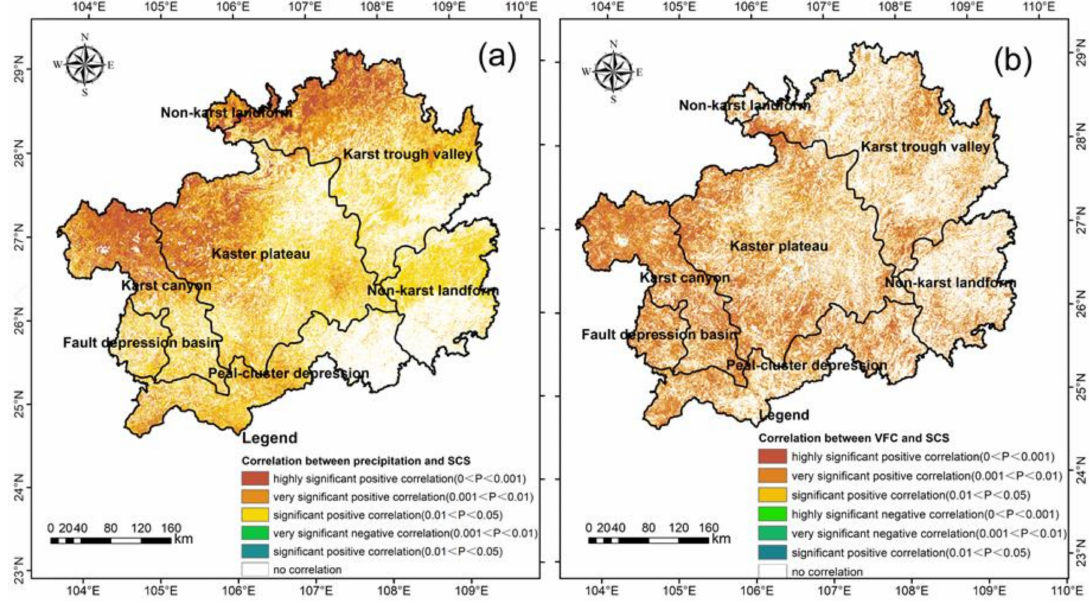
Figure 12. Correlation and t-test statistic of changes in ( a ) precipitation and SCS and ( b ) VFC and SCS on the Guizhou